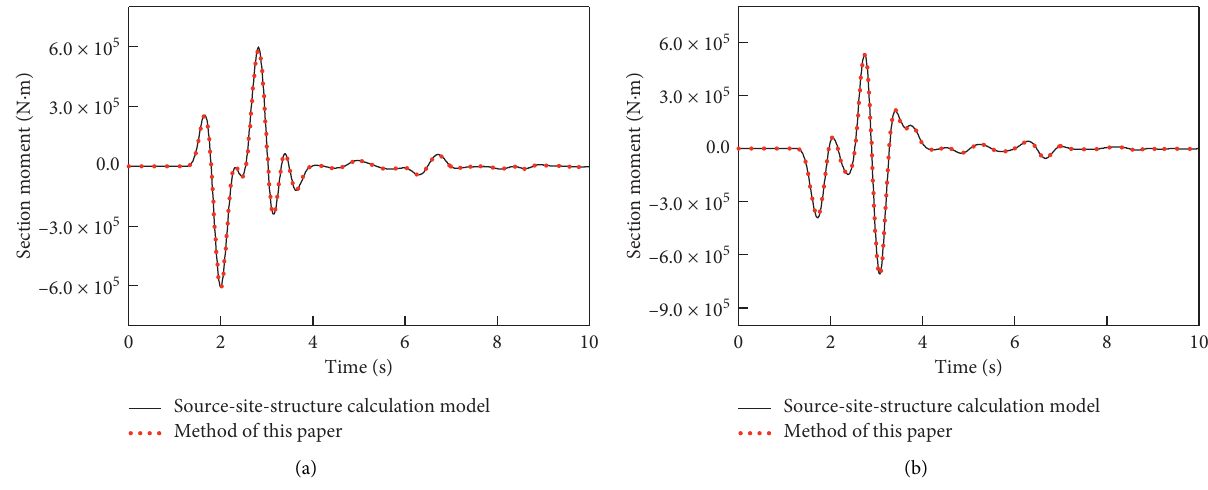
Figure 15: Comparison of bending moment values of structural section (burial depth is 200m): (a) section (A), (b) section C.